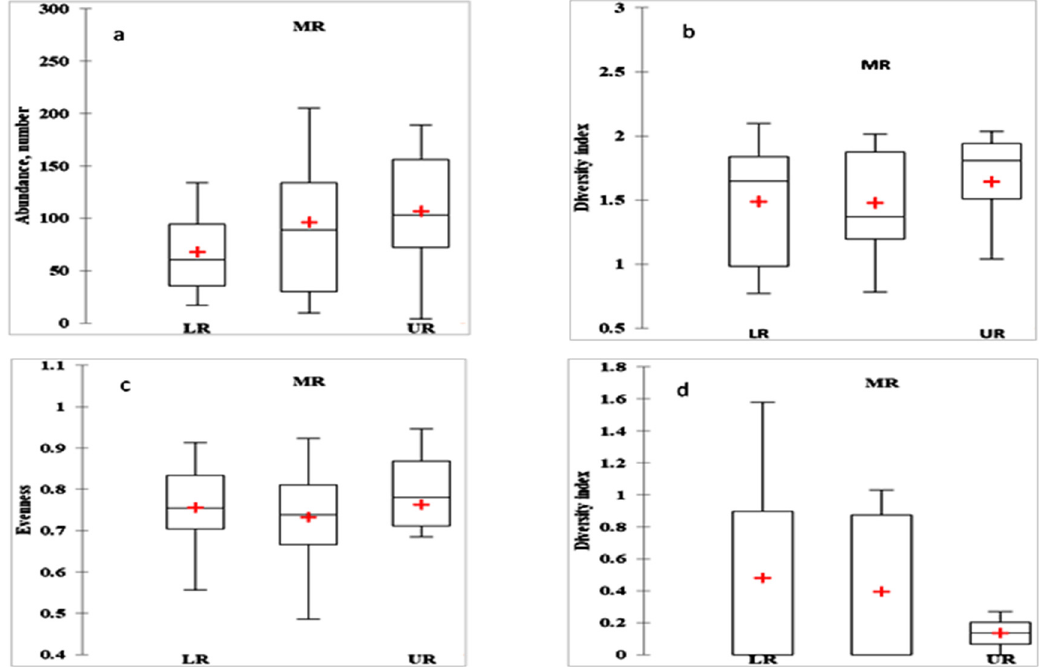
Figure 5. Macroinvertebrate abundance ( a ), diversity ( b ), evenness ( c ), and fish diversity ( d ) across the three reaches of the Gumara river. LR—lower reach, MR—middle reach, and UR—upper